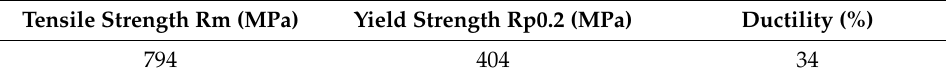
Table 4. Mechanical properties of AISI 304 stainless